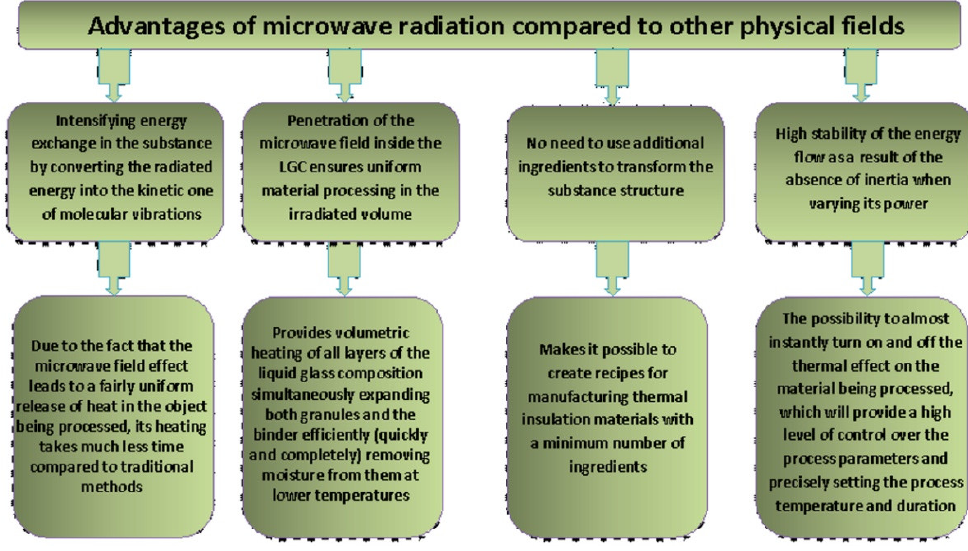
Figure 8. Advantages of microwave exposure for manufacturing TIM based on LG.